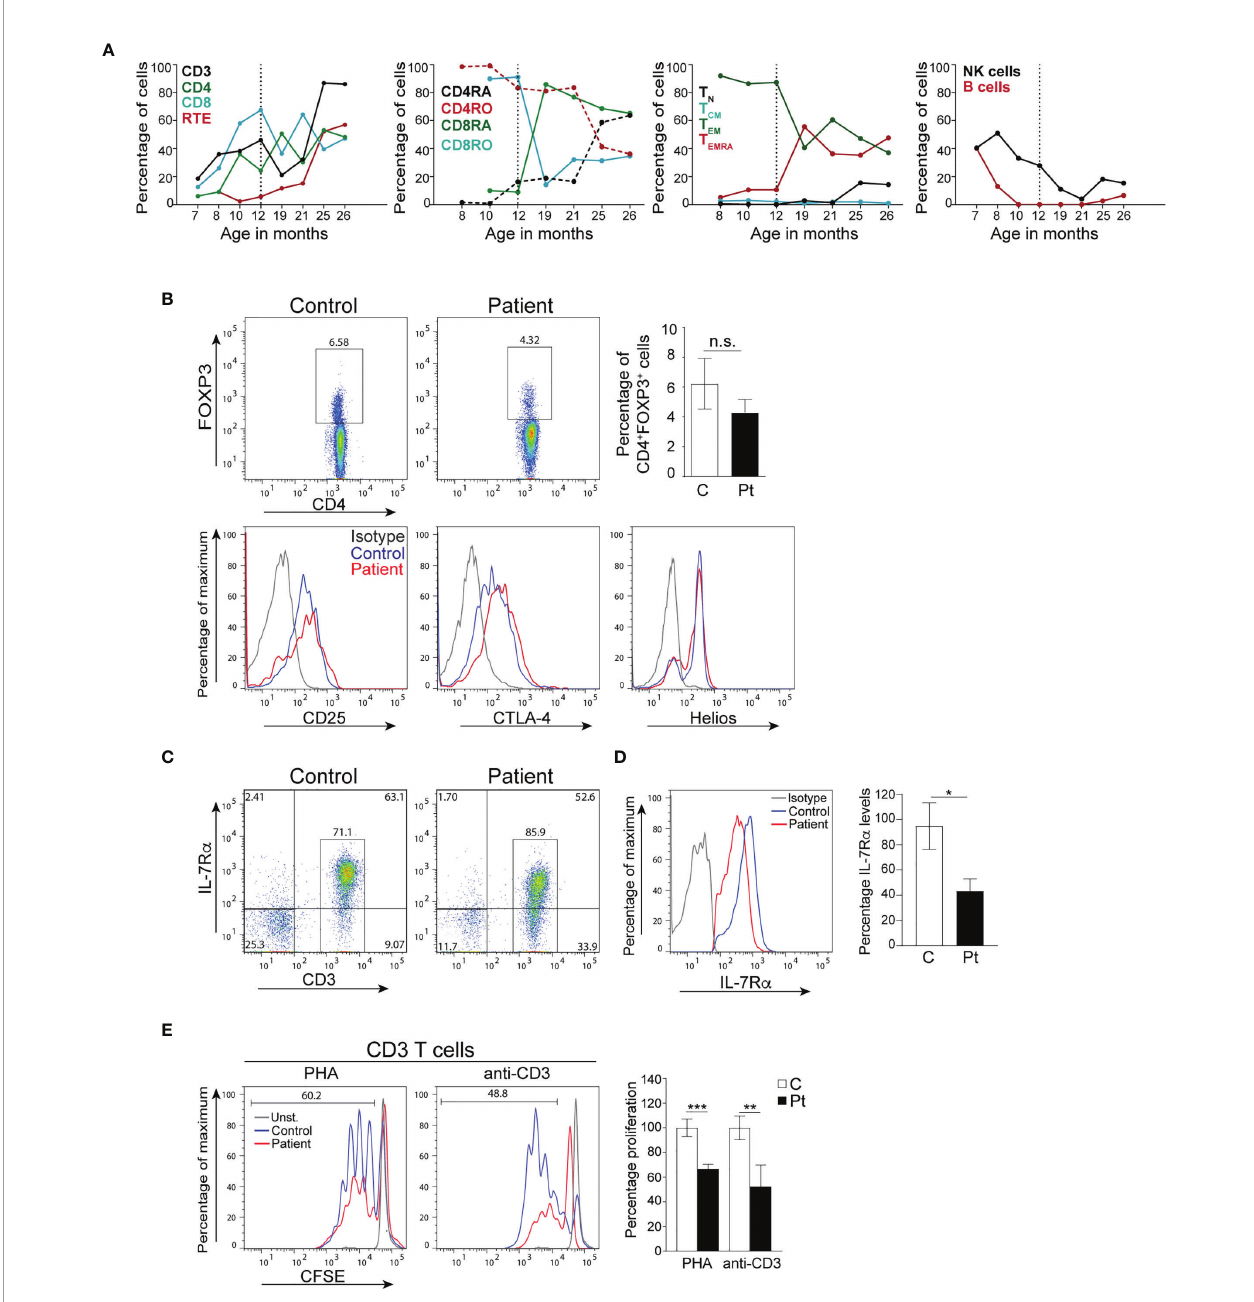
FIGURE 4 | Immune reconstitution and T cell function of the patient cells. (A) Percentages of immune cells before and after bone marrow transplantation. The broken vertical line represents the age at transplant. (B) Percentages of CD4 + FOXP3 + Treg cells, and expression of the effector proteins CD25, CTLA-4, and Helios by Tregs in the patient 14 months post-transplant. Columns and bars represent the mean ± SEM of CD4 + FOXP3 + Treg cells. N=3 controls and the patient done in 3 independent experiments. (C) Representative dot plot analysis of IL-7R a cell surface expression on donor-derived CD3 + T cells from the patient and a control. (D) Histograms represent the levels of IL-7R a expression (MFI) on CD3 + T cells. Columns and bars represent the mean ± SEM of the levels of IL-7R a expression (MFI) with the healthy controls set at 100%. N = 3 controls and the patient done 3 times. (E) T cell proliferation in PBMCs from the patient post-transplant. Columns and bars represent the mean ± SEM of the percentage T cell proliferation with the healthy control set at 100%. N = 3 healthy controls and the patient done in 3 independent experiments. ***p < 0.001; **p < 0.01; *p < 0.05; n.s., not signi fi cant. C, control; Pt,